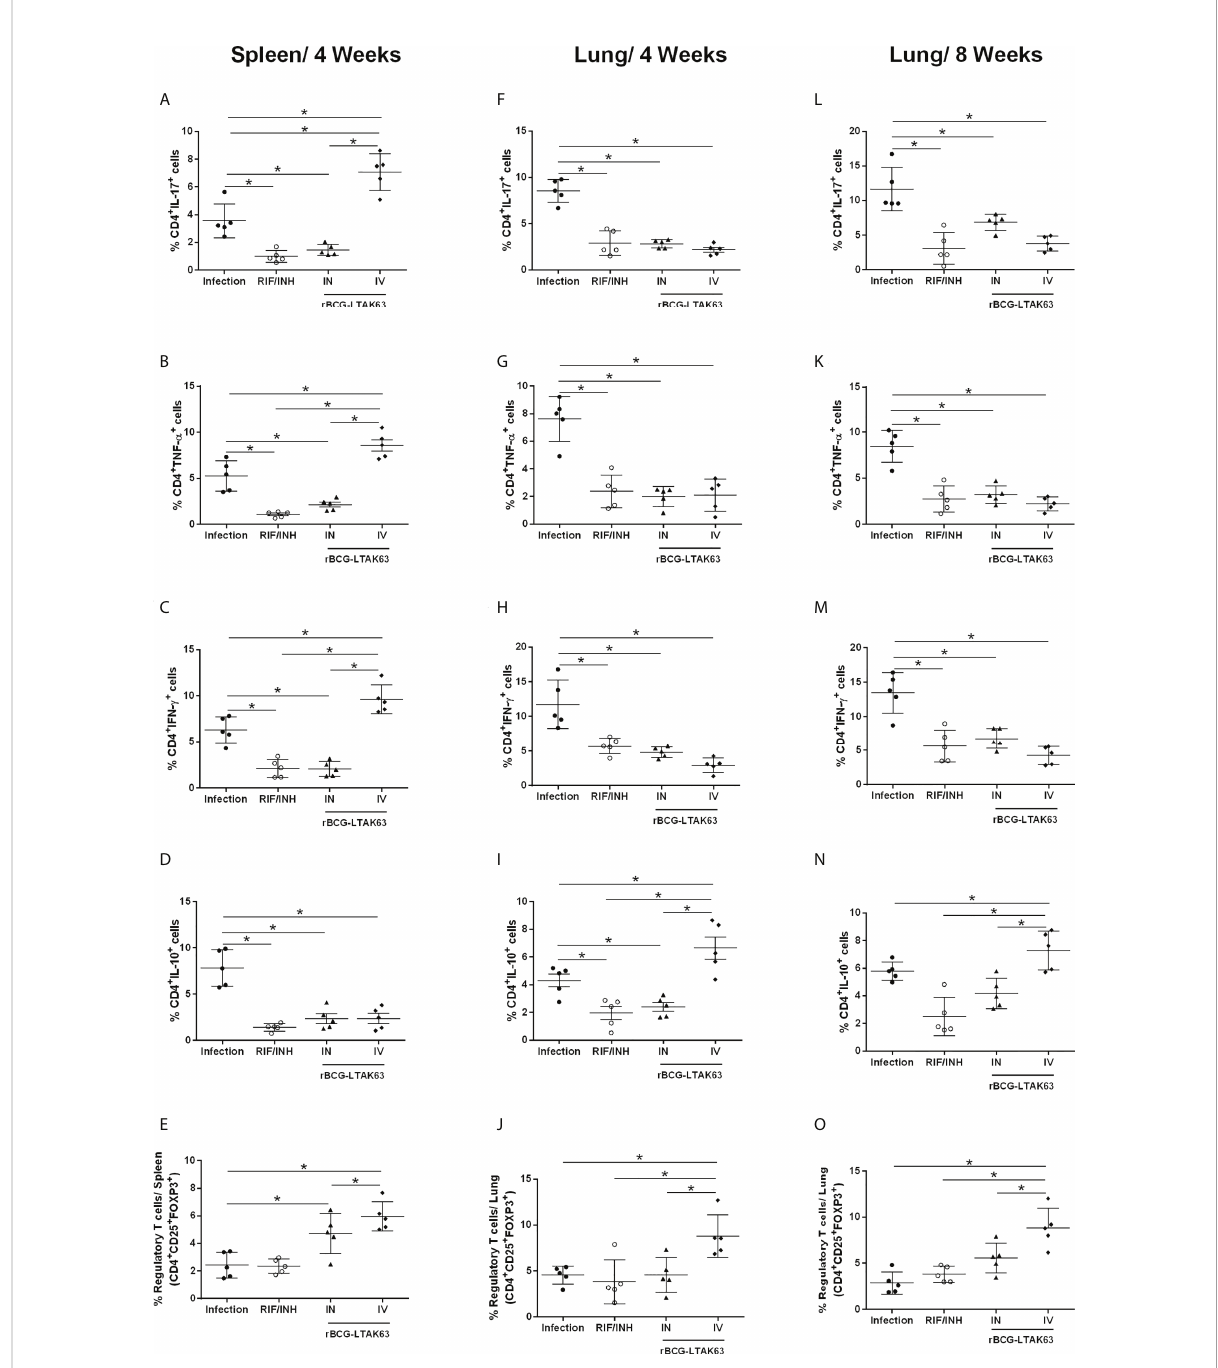
FIGURE 3 Immunotherapy with rBCG-LTAK63 modulates proin fl ammatory and regulatory immune responses in Mtb -infected mice. BALB/c mice were infected with Mtb (Infection) and treated with RIF/INH ( via gavage for 4 weeks) or a single dose of rBCG-LTAK63 delivered intranasally (IN) or intravenously (IV). The immune response in the spleen and lungs was evaluated four and eight weeks post-treatment (4wpt and 8wpt). The number of CD4 + T cells producing IL-17, (A, F, L) TNF- a (B, G, K) , IFN- g (C, H, M) and IL-10 (D, I, N) in these organs was determined by staining with mouse monoclonal antibodies anti-CD3-APC.CY7, anti-CD4-PercP and anti-IL17-BV421, anti-TNF-PE, anti-IFN-APC or anti-IL-10-PE.Cy7. The percentage the regulatory T cells was determined by staining with mouse monoclonal antibodies anti-CD4-PercP and anti-CD25-PE and anti-FoxP3-APC (E, J, O) , and analyzed using Flow Cytometer FACS Canto II and FlowJo 8.7 software. Statistical differences were determined by one-way ANOVA with a Bonferroni test. * p values ≤ 0.05 were considered statistically signi fi cant. Asterisks over the columns refer to the comparison with the infection group. Results are represented by the means ± SD of the percentage of CD4+ T cells (for IL-17, TNF- a , IFN- g and IL-10) or the percentage of regulatory T cells in the CD4 + population